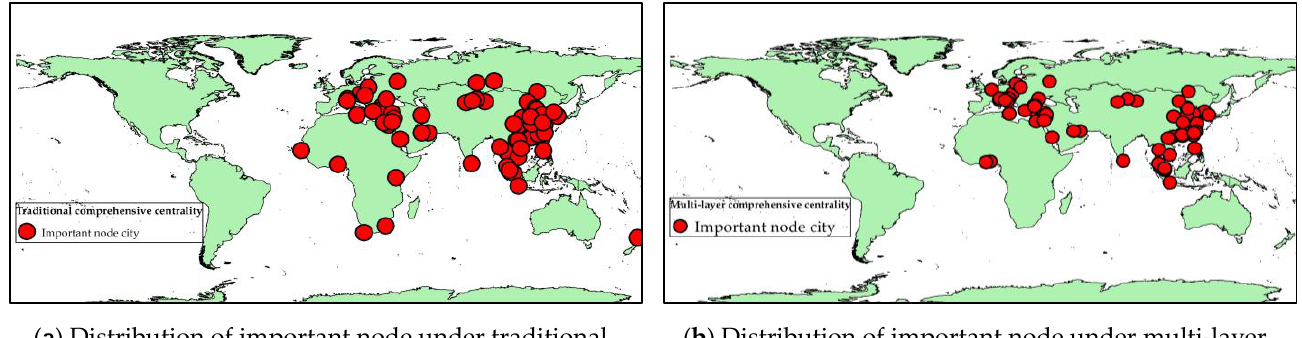
Figure 10. Distribution of important node cities with different comprehensive centrality.